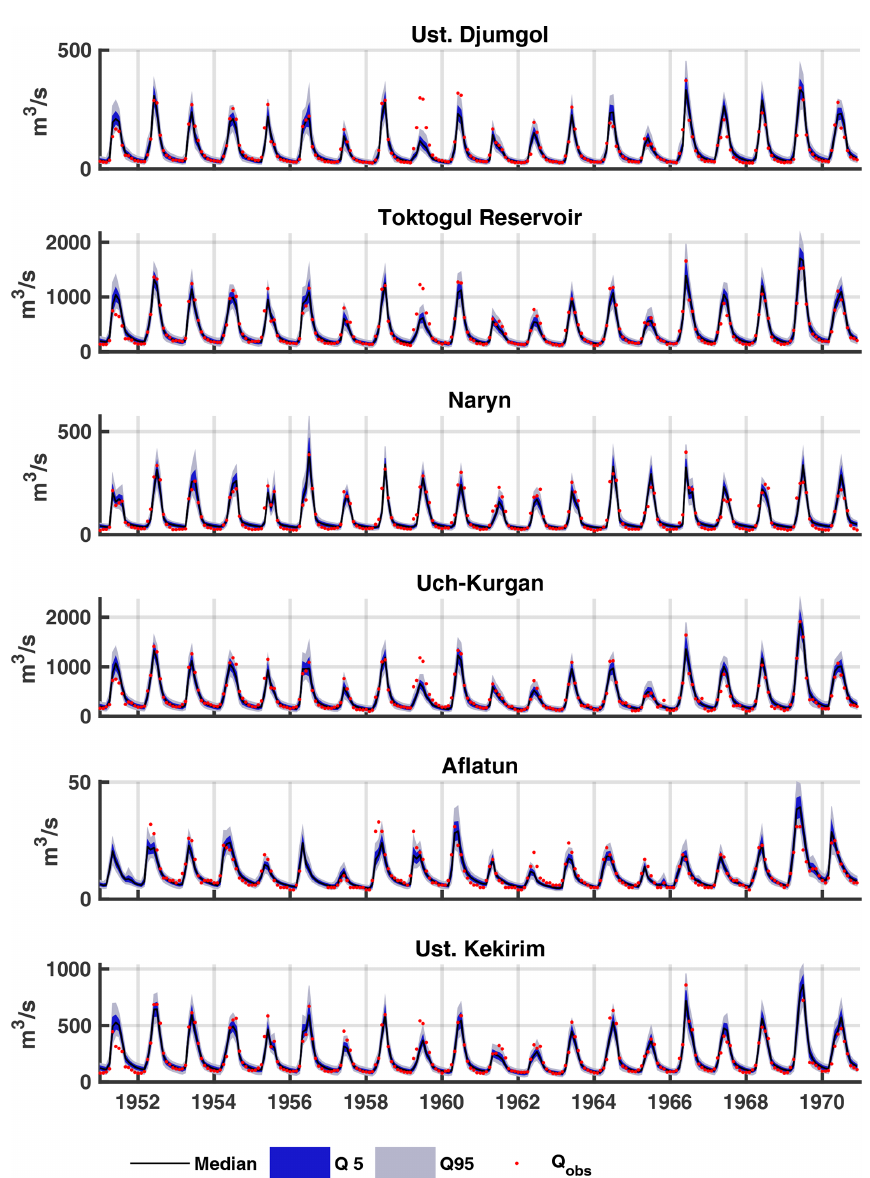
Figure 4. Observed and simulated discharge for the calibration period when parameters are selected for individual sub-catchments (MSC method). The shaded envelopes show the 5th–95th percentile ranges and the black line shows the 50th percentile of the best 0.5%